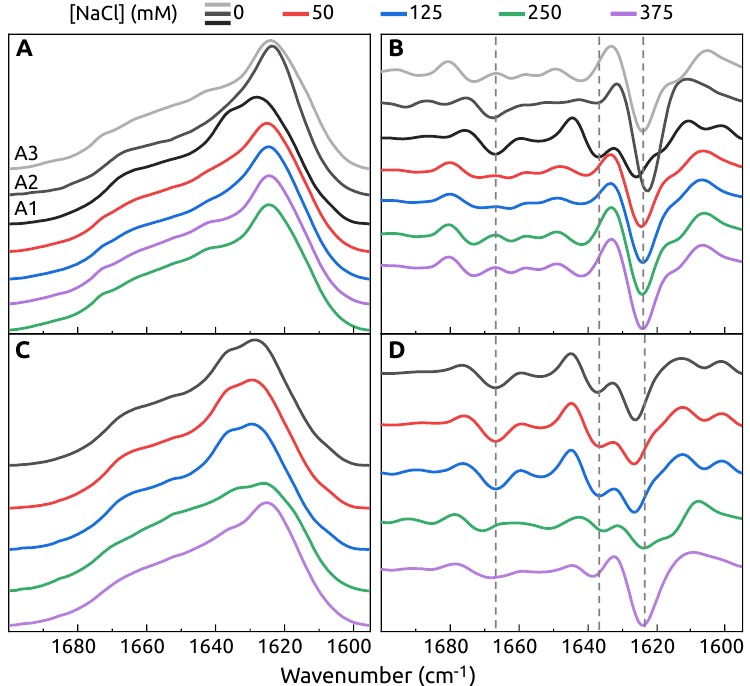
Figure 5. FTIR spectra ( A , C ) and second derivative ( B , D ) of α -syn (70µM) without or with 35µM S100A9 in PBS buffer with different concentration of NaCl. When the samples for aggregation are composed of 70 µM α -syn, 35 µM S100A9 and different concentrations of additional NaCl, the presence of 50 mM or 125 mM NaCl does not affect the secondary structure of the resulting fibrils (Figure 5C,D). The